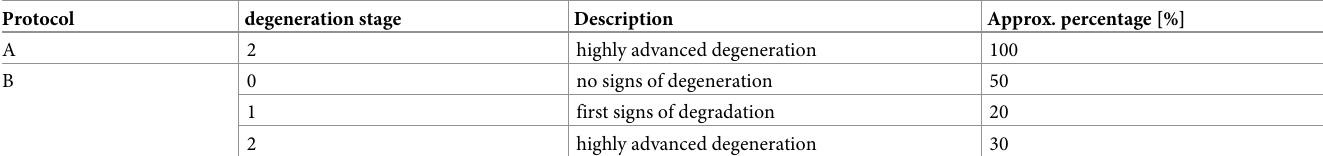
Table 2. Summary of ultrastructural analysis of storage cells in typical tuns. For the analysis, 10 tuns obtained by protocol A and 10 tuns obtained by protocol B were randomly selected.